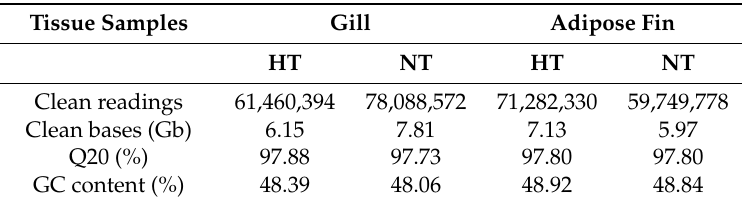
Table 1. Generated readings expressed by Illumina for the gill and adipose fin tissues of individuals from the HT and NT